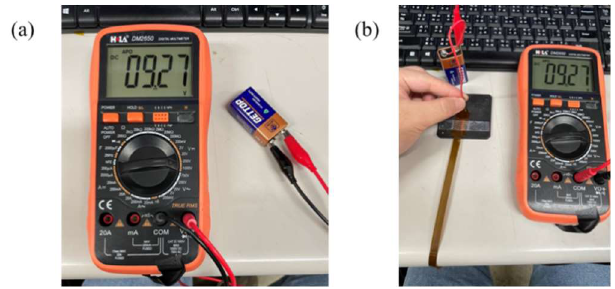
Figure 6. ( a ) Cell voltage measurement; ( b ) micro voltage sensor measurement cell.